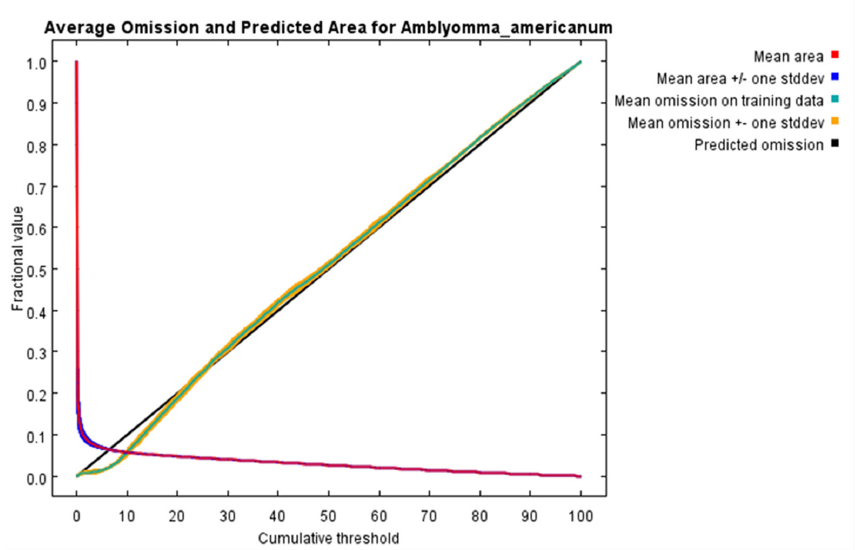
Figure 1. The output of the Maxent model’s for the training omission rate and predicted area as a function of the cumulative threshold.